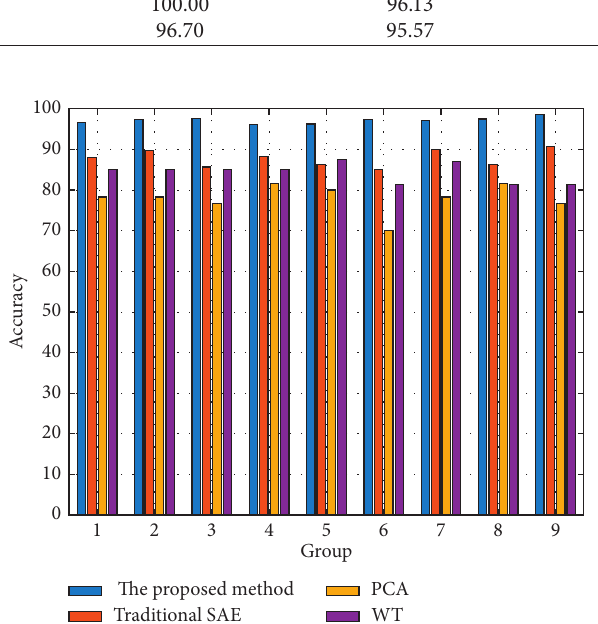
Figure 10: Diagnosis results of the 9 groups with 4